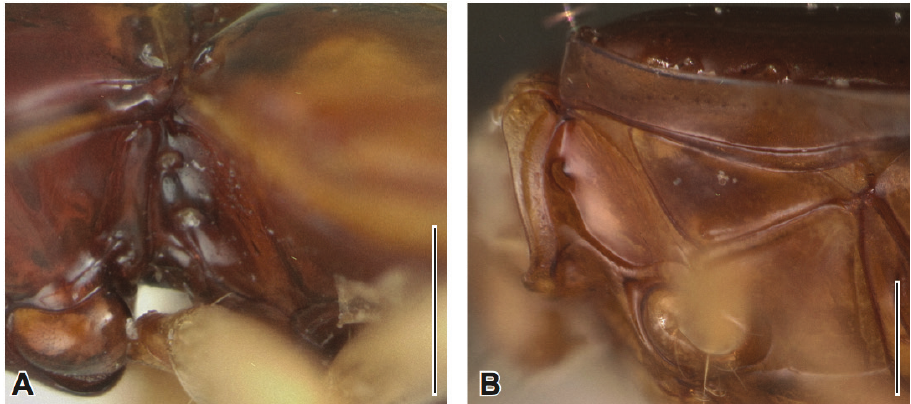
Figure 7. Mesepisternal pits of new Tachyina. A Elaphropus ( Nototachys ) occidentalis (paratype, ♂ ) Perú, Loreto B Meotachys ( Hylotachys ) ballorum (paratype, ♀ ), Brazil, Amazonas, Rio Demiti. Scale bars = 0.25